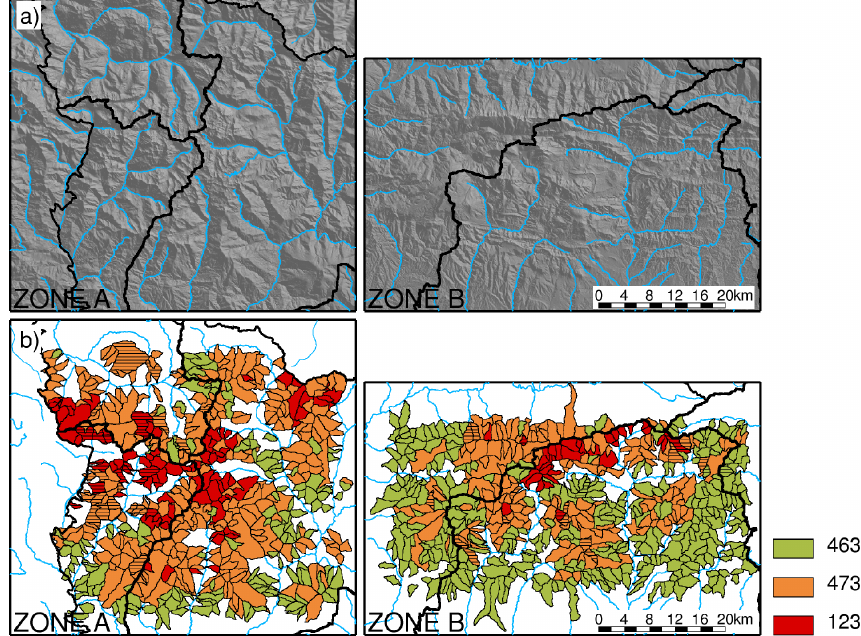
Figure 6. (a) Hillshade map of the analysis domain; (b) DF susceptibility classification based on the highest membership degree in each subbasin (green, orange and red indicate subbasins with susceptibility classified as “low”, “moderate” and “high”). Reactive subbasins are filled with a horizontal line pattern. The legend on the right indicates the number of subbasins corresponding to each susceptibility class.